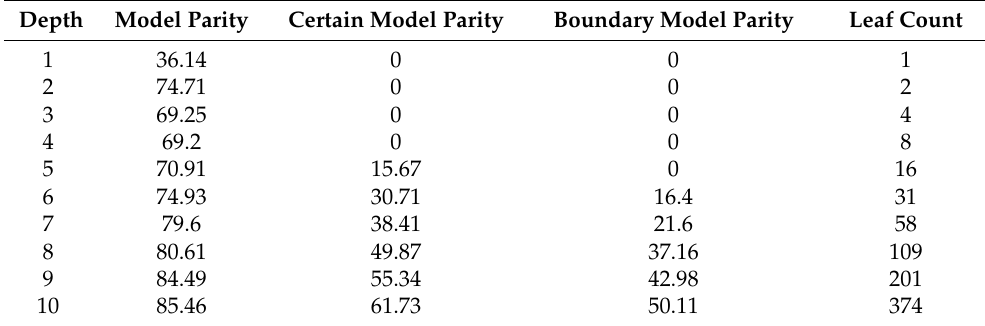
Table 5. Evaluation of the interpretable models for the Abalone dataset generated by TRE-PAN at depths ranging from 1 to